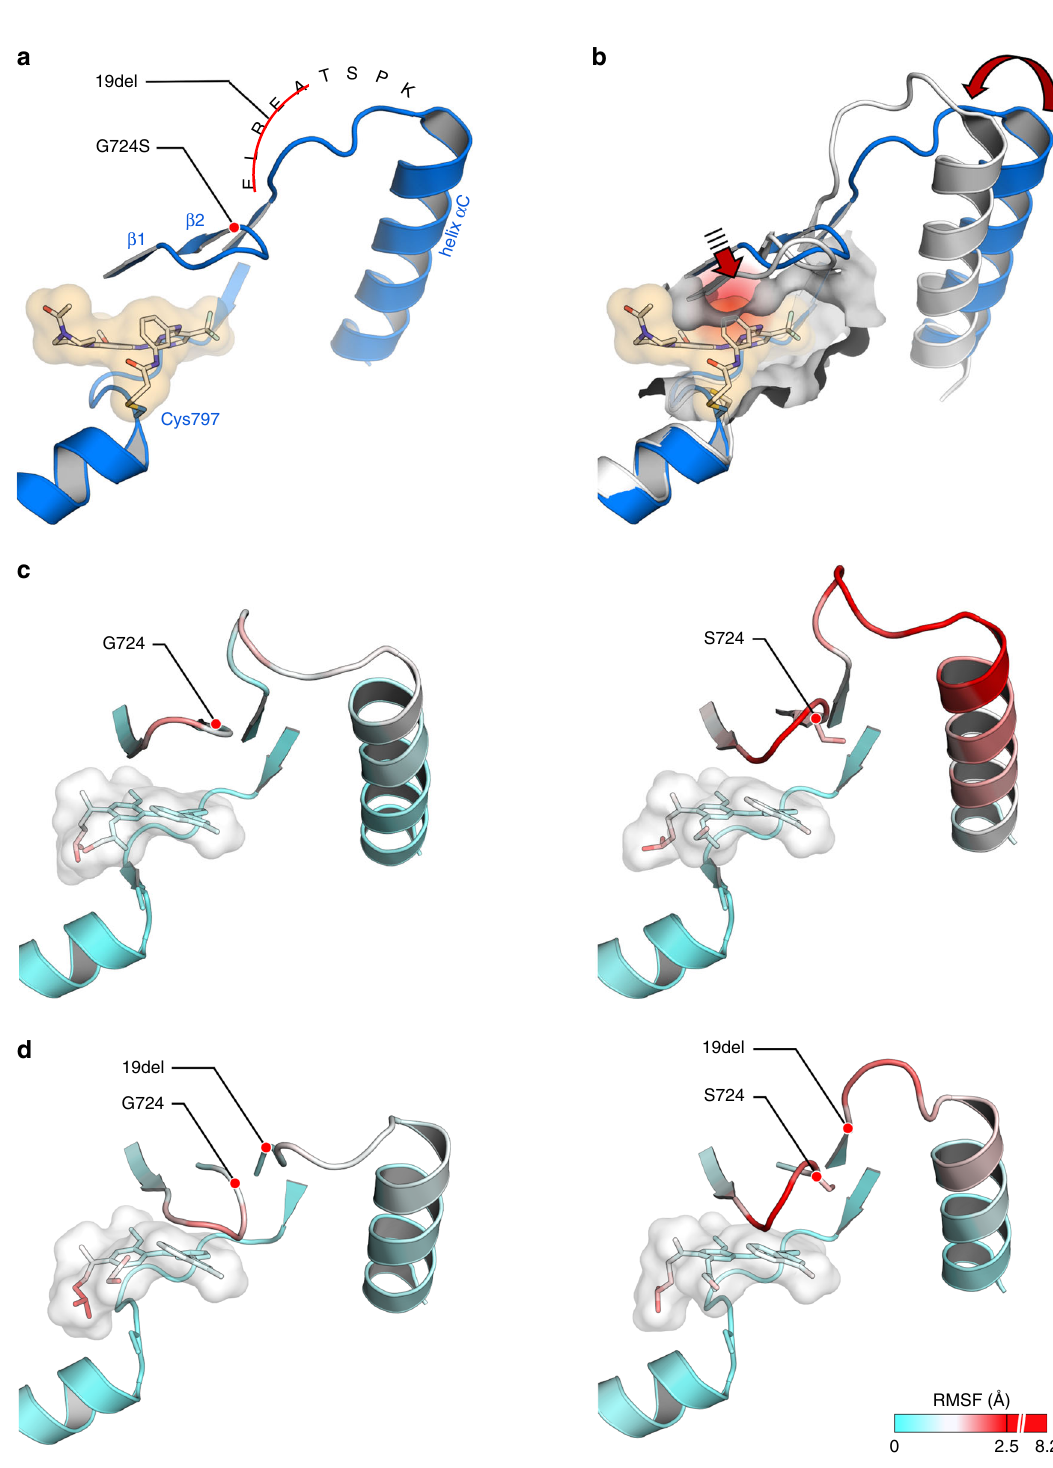
Fig. 3 Structural analysis of EGFR 19del + G724S . a Binding site of rociletinib bound EGFR (PDB ID: 5UWD). b Alignment of the rociletinib bound EGFR-binding site (blue, PDB ID: 5UWD) with exon 20-mutant EGFR (white, PDB ID: 4LRM) that reveals steric hindrance of third-generation TKIs with the glycine-rich loop and the adjacent sheet β 1 upon a perturbed network between helix α C, ELREA motif, and glycine-rich loop. c Comparison of MD simulations of osimertinib bound EGFR WT (left), EGFR G724S (right) (based on PDB ID: 4ZAU). d Comparison of MD simulations of osimertinib bound EGFR 19del (left) or EGFR 19del + G724S (right) (based on PDB ID: EGFR 19del + G724S -mutant tumors that received osimertinib (Sup- plementary Fig. 2B – F).